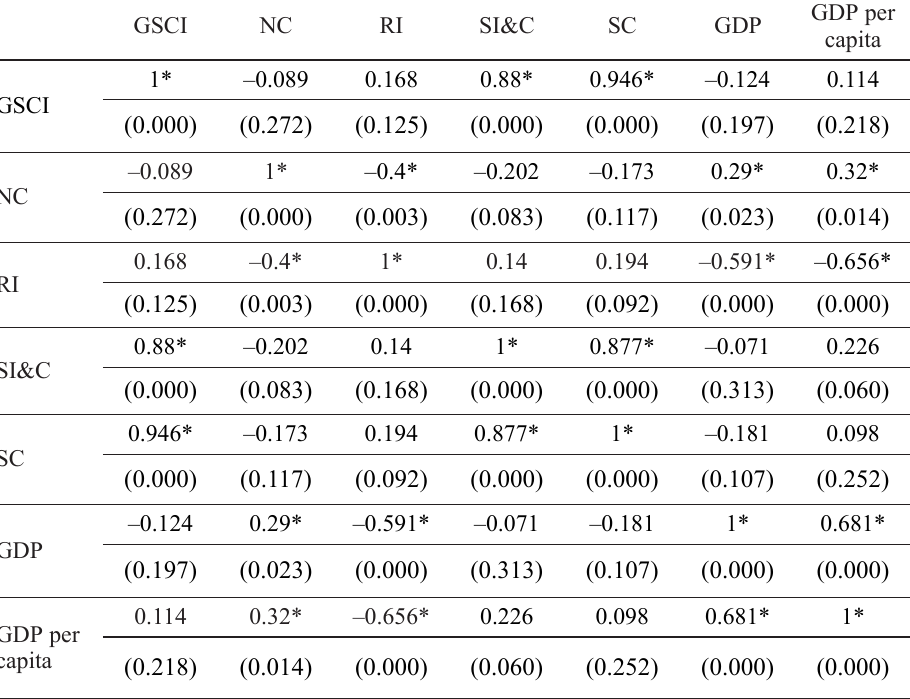
Table 3. Correlations between fund rankings on sustainability indicators and on GDP GSCI